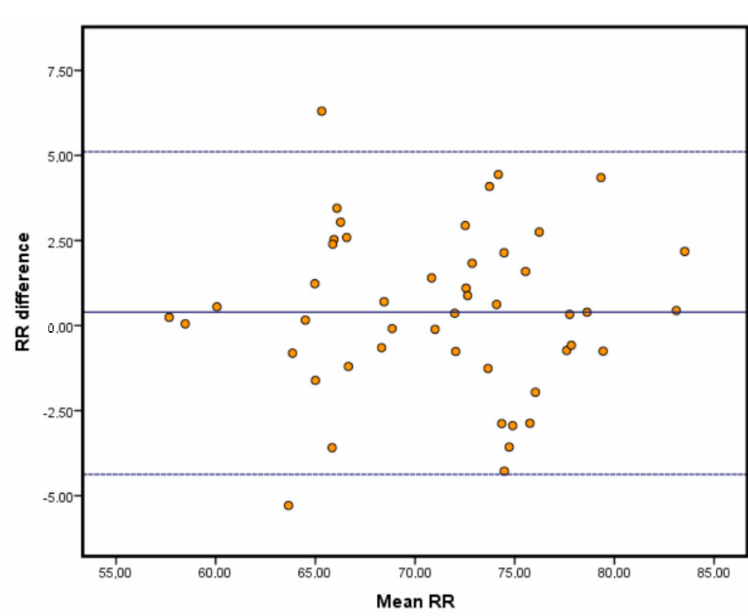
Figure A5. Bland-Altman plot right